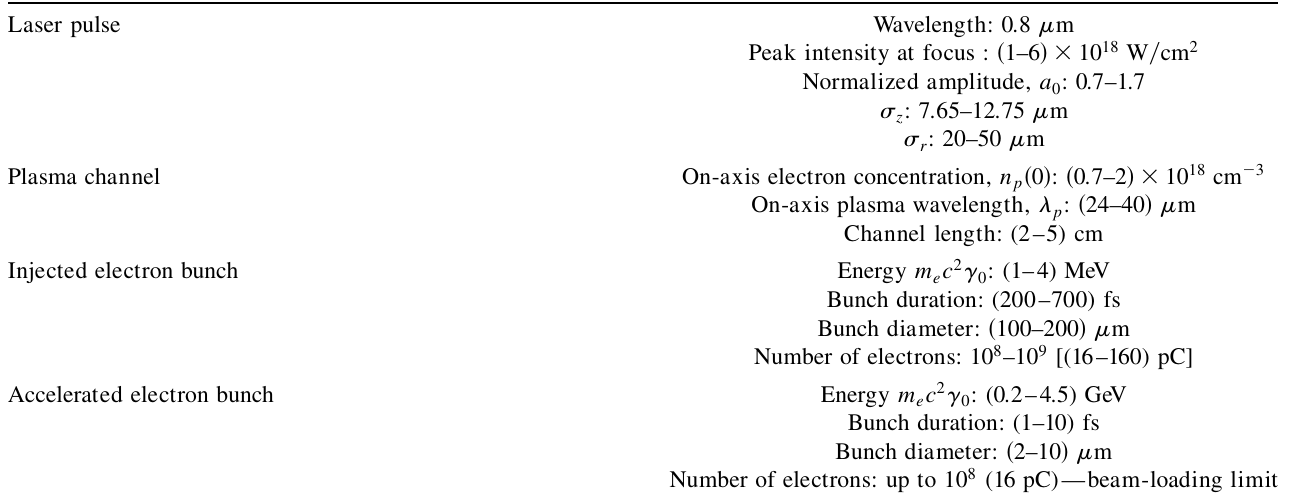
TABLE I. Parameters for proof-of-principle experiment with (cid:21) 1 J , (30-50) fs laser pulse. Laser pulse